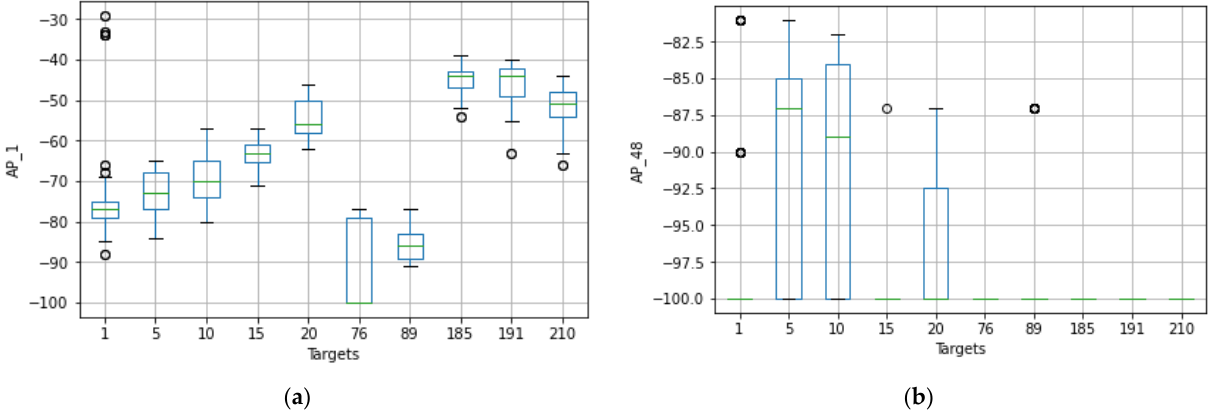
Figure 25. Distribution analysis of Wi-Fi RSS testing measurements of different APs based on box and whisker plot. The small circles found above and below the whisker box plot represents the outliers of the testing measurements received from the Wi-Fi APs of ( a ) AP_1 and ( b ) AP_48.